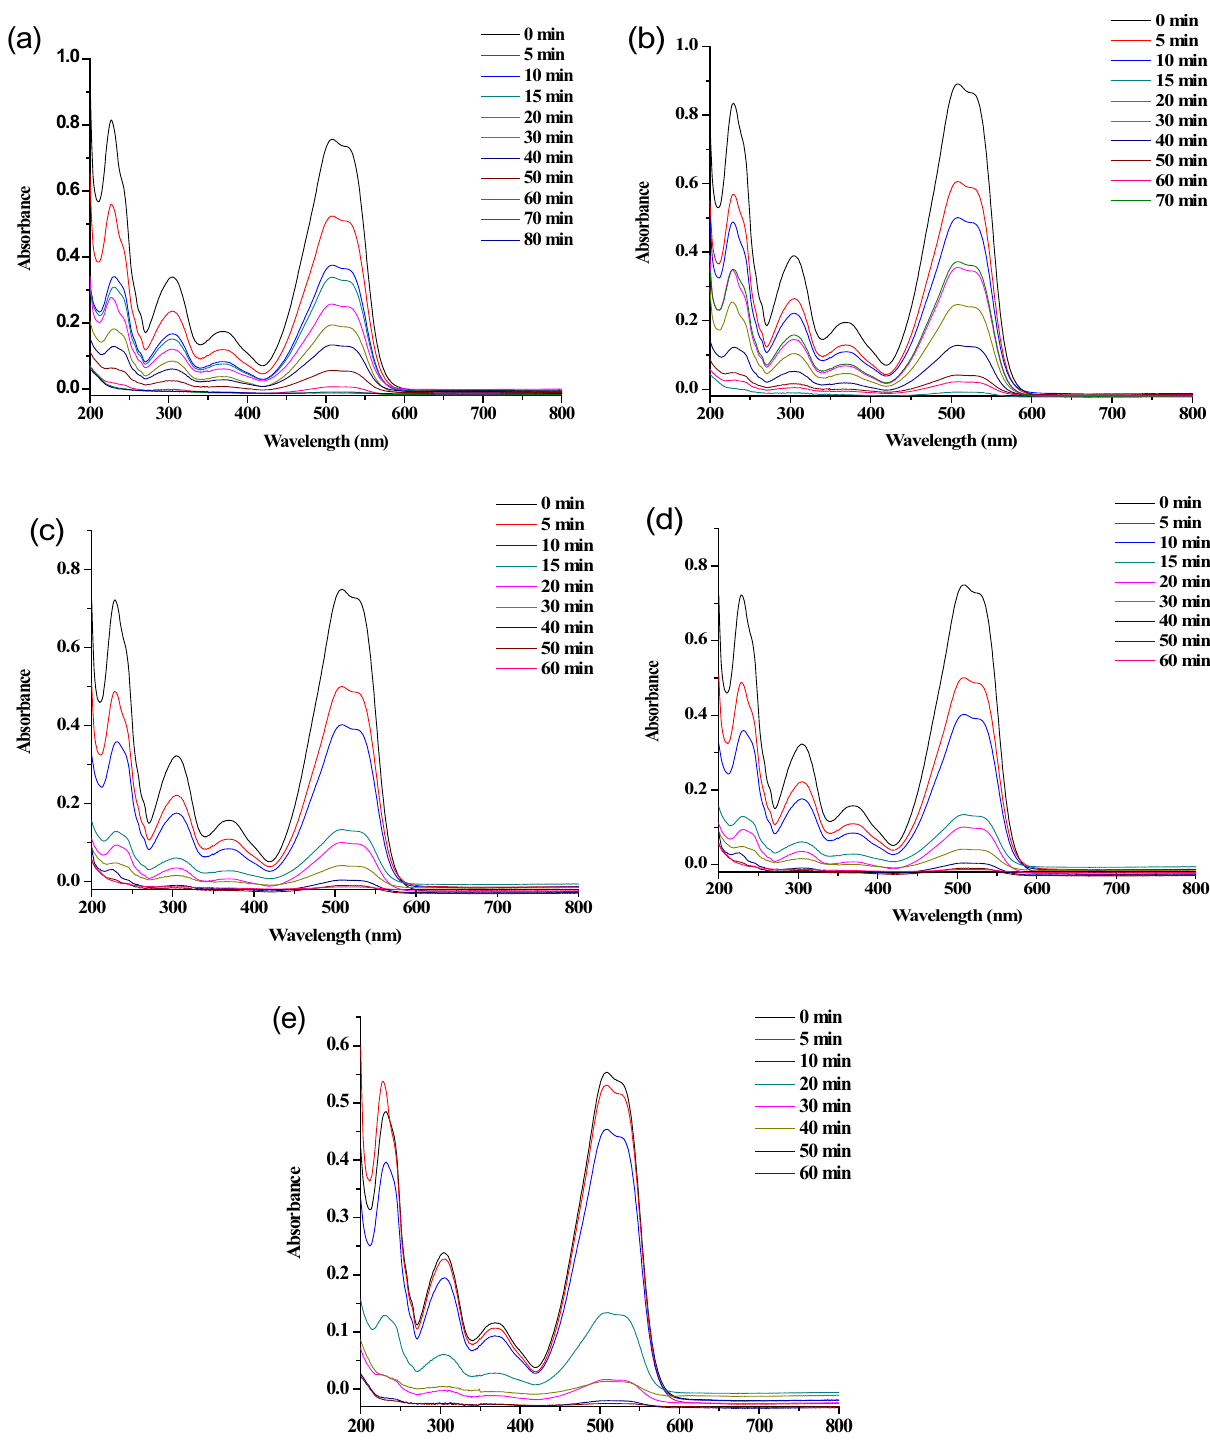
Fig. 10 UV–Vis absorption spectra for oxidative degradation of Chromotrope 2R with MVPA/Kaolin loads of 1 g L −1 ( a ), 3 g L −1 ( b ), 5 g L −1 ( c ), 8 g L −1 ( d ) and 10 g L −1 ( e